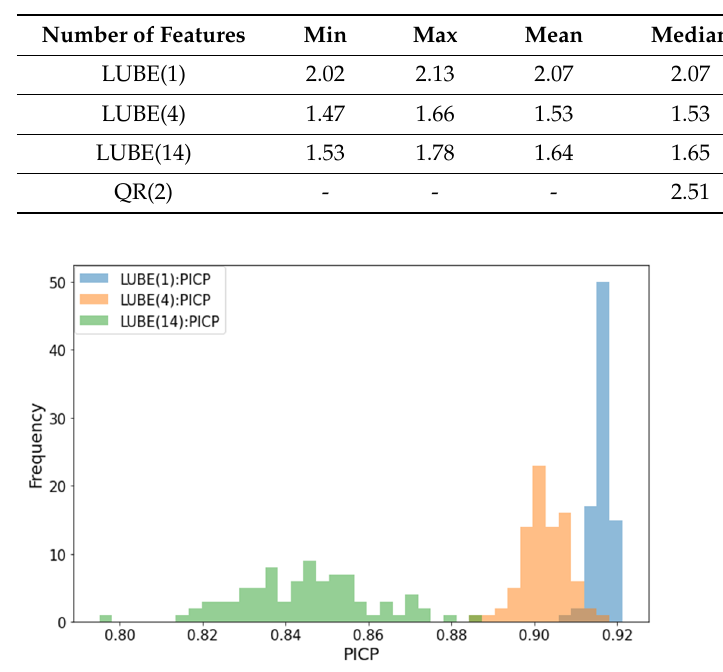
Table 5. Statistics of 2-week average MPIW.